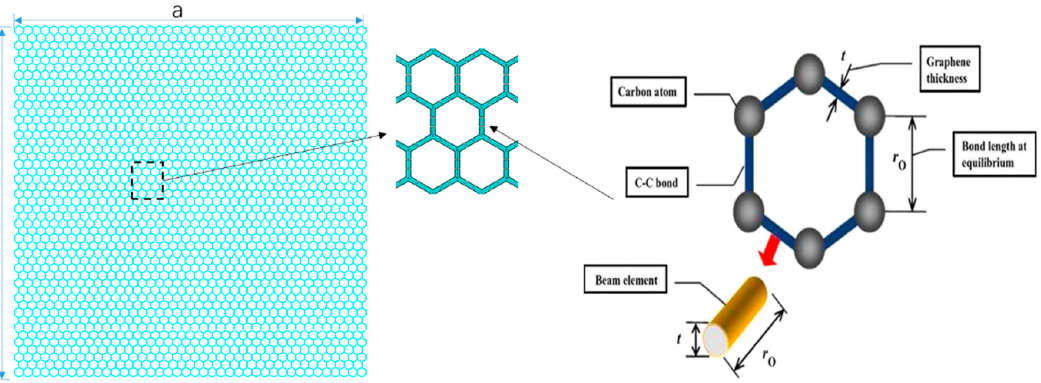
Figure 1. Schematic of a monolayer graphene.